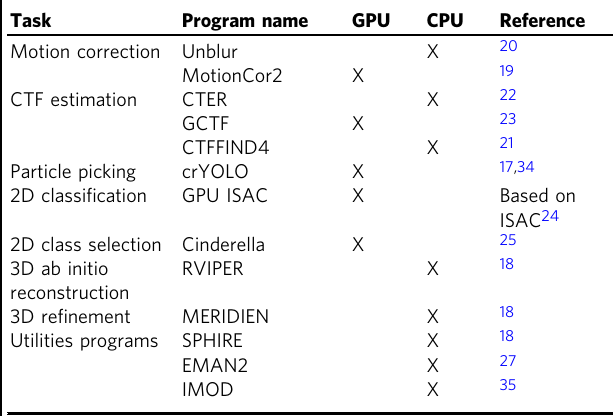
Table 1 Hardware utilization for software tools supported by TranSPHIRE.